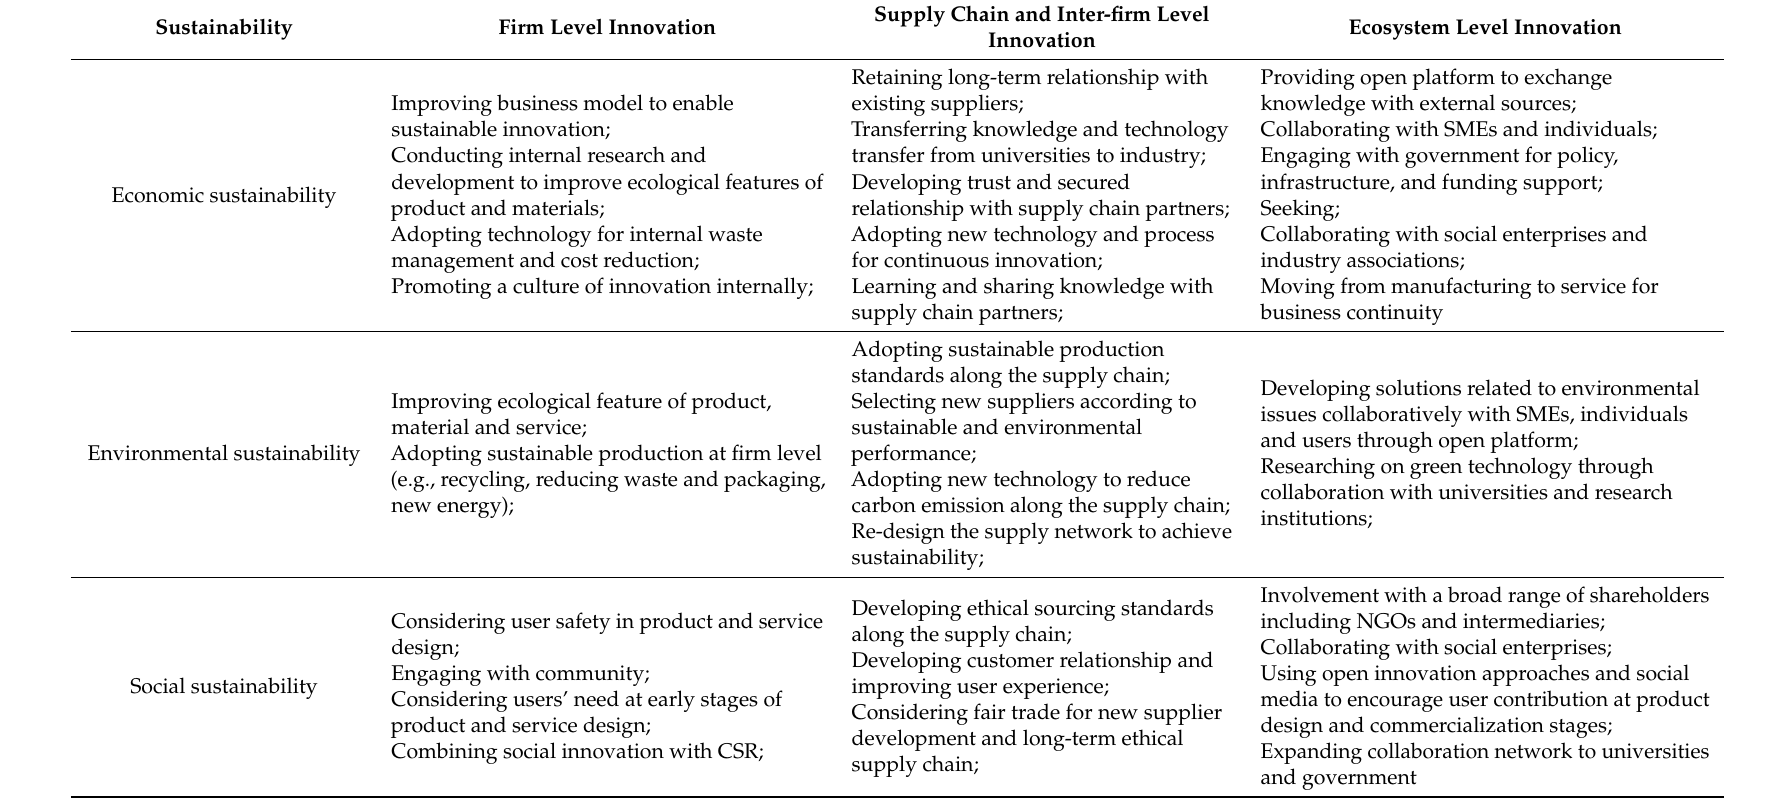
Table 2. A summary of sustainability innovation activities at di ff erent